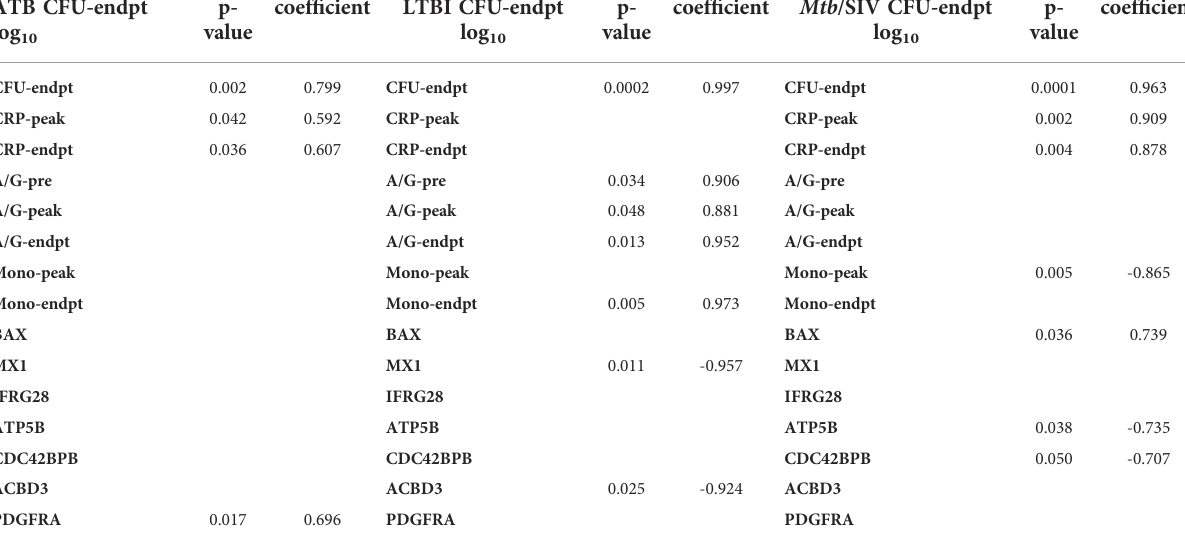
TABLE 2 Pearson Correlations to CFU/gm(log 10 ). All correlations were made between CFU and clinical metrics or genes. ATB CFU-endpt log